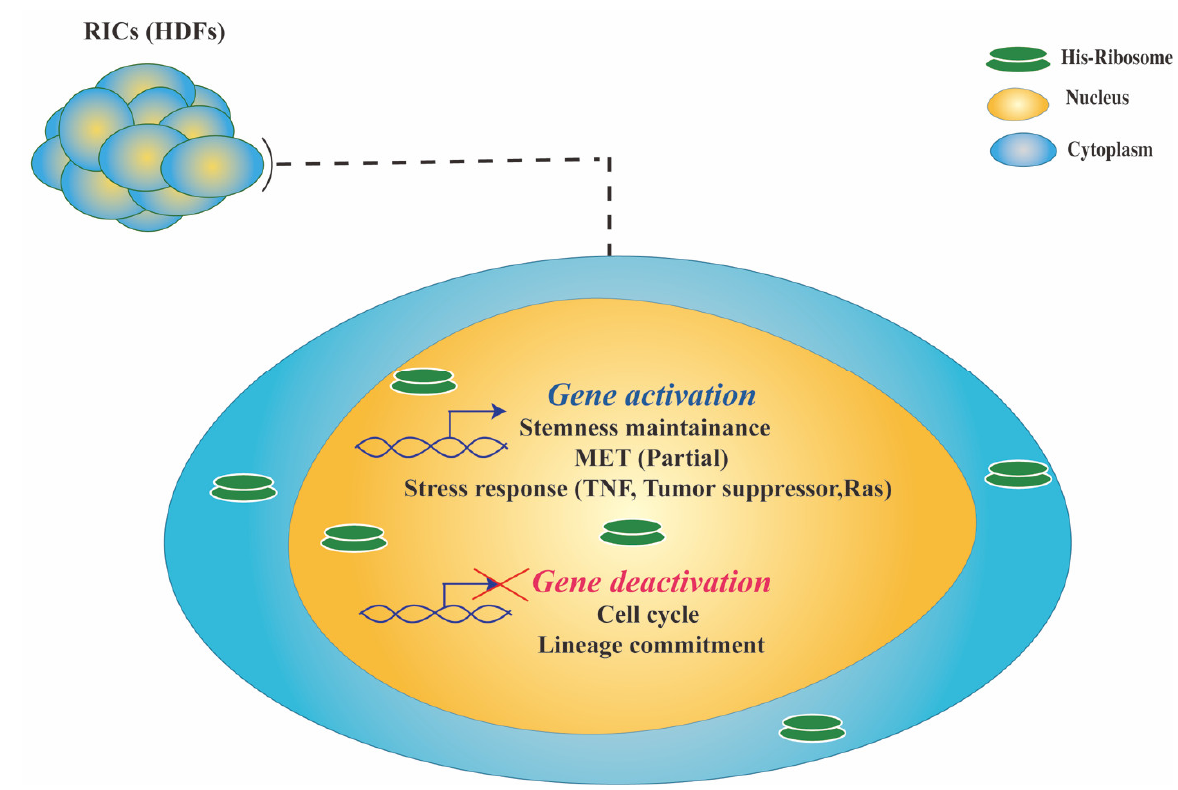
Figure 2. Summary of ribosome incorporation-mediated gene regulation in RICs.